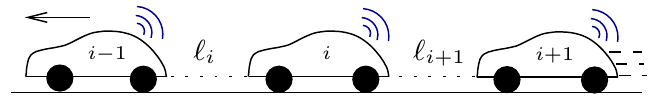
Figure 1. Platoon of vehicles with wireless